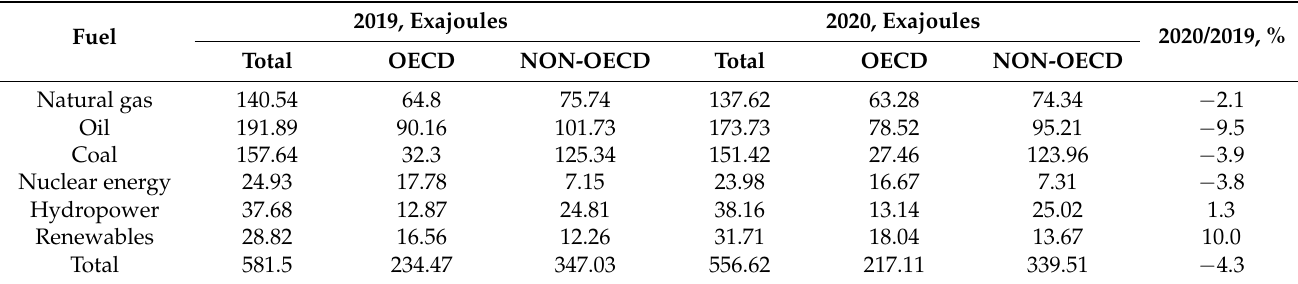
Table 1. Energy consumption by fuel type (created by the authors, based on